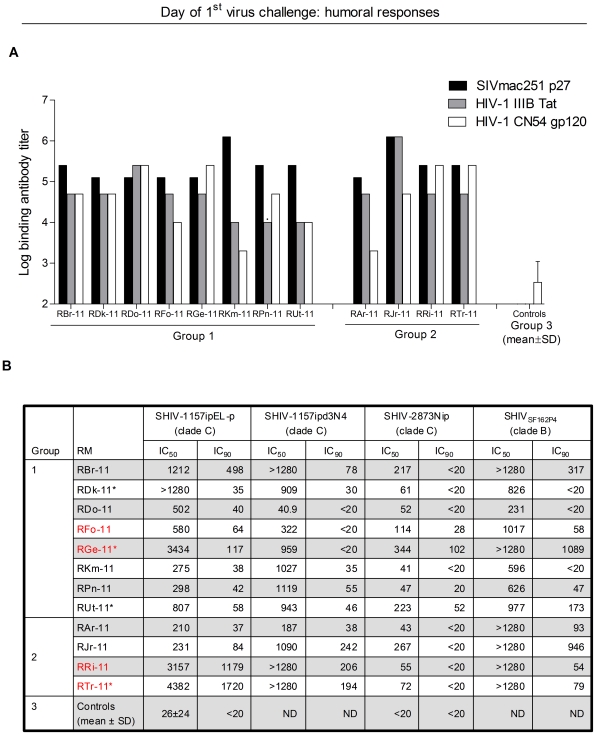
Humoral immunity at the time of initial low-dose SHIV-1157ipEL-p challenge.(A) Reciprocal serum antibody ELISA titers against SIVmac251 p27 Gag, HIV-1 Tat and heterologous clade C HIVCN54 gp120. (B) NAb activity SHIV-1157ipEL-p and, SHIVSF162P4) and Tier 2 (SHIV-1157ipd3N4, SHIV-2873Nip) viruses was measured in human PBMC in the presence of polymyxin B. TZM-bl neutralization assay was also performed against SHIV-1157ipEL-p. IC50 and IC90 titers, reciprocal dilutions of serum giving 50% and 90% neutralization (inhibitory concentrations), respectively, are shown. *, Mamu A*001-positive RM.